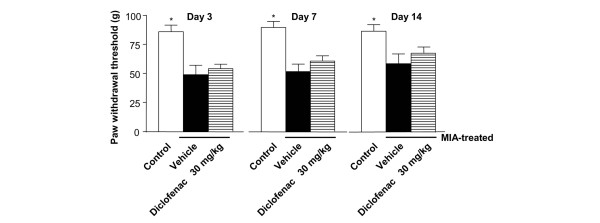
Effect of diclofenac on tactile allodynia after monosodium iodoacetate (MIA) injection. Effect of diclofenac on paw withdrawal threshold in the von Frey filament test in iodoacetate-treated animals on days 3, 7 and 14 after arthritis induction. Rats were tested 45 to 60 minutes post drug. Data from12 animals/group are presented as mean ± SEM. *P < 0.05 Dunnett's test versus MIA/vehicle treated animals.